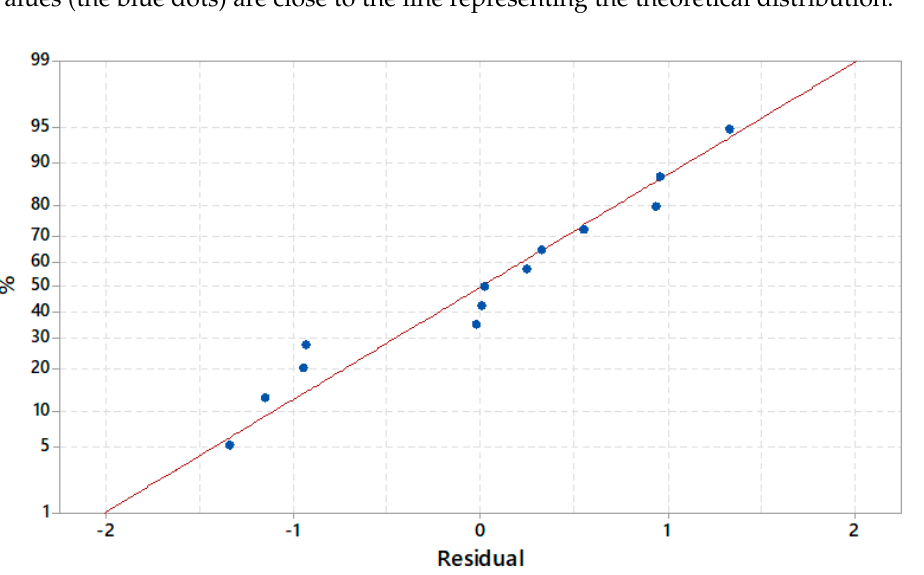
correlogram indicated the absence of